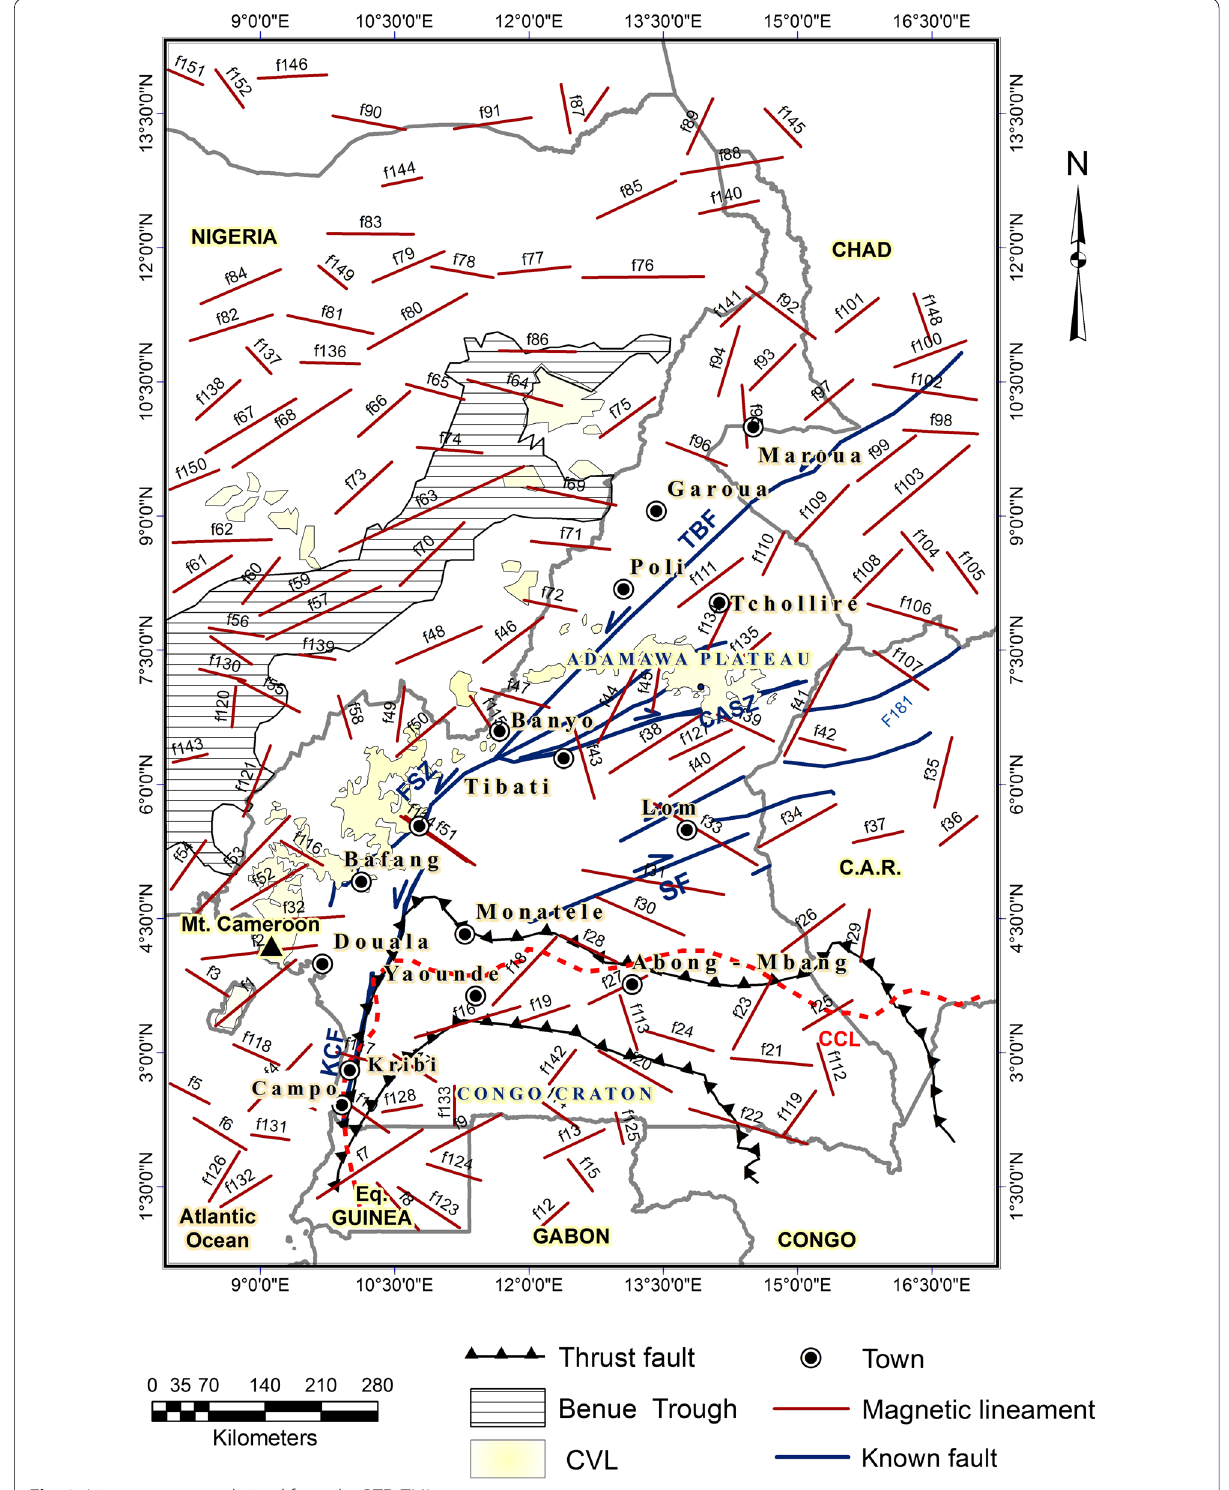
Fig. 9 Lineaments map derived from the